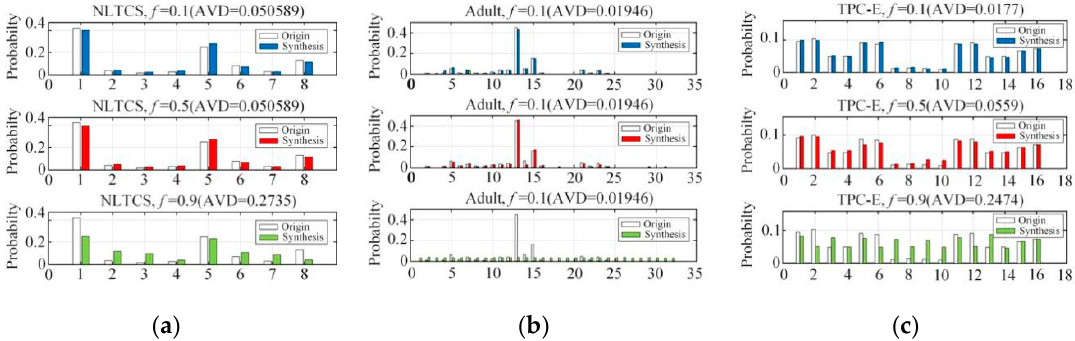
Figure 8. Probability distribution estimation under different ranges |𝛺| : ( a ) NLTCS ( |𝛺| = 8 ), ( b ) Adults ( |𝛺| = 32 ), ( c ) TPC-E ( |𝛺| = 16 ).